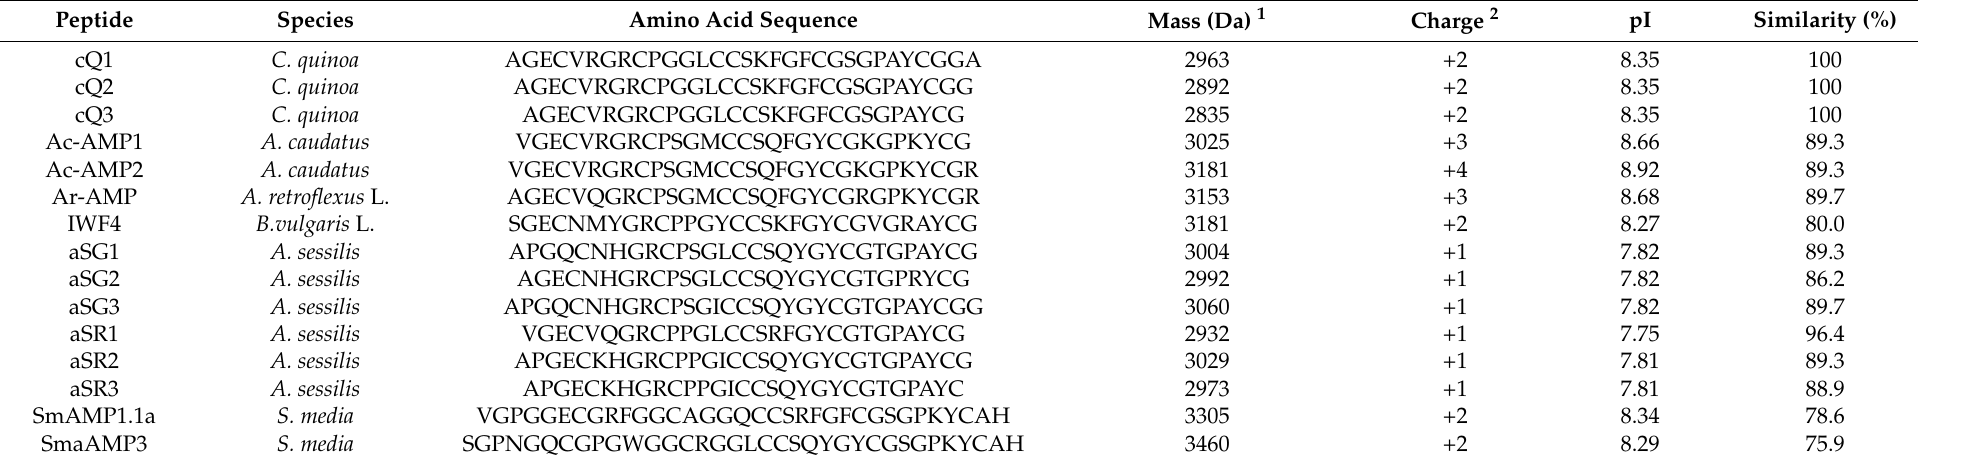
Table 1. Sequence comparison of the primary peptide sequences of chenotides and reported six-cysteine chitin-binding hevein-like